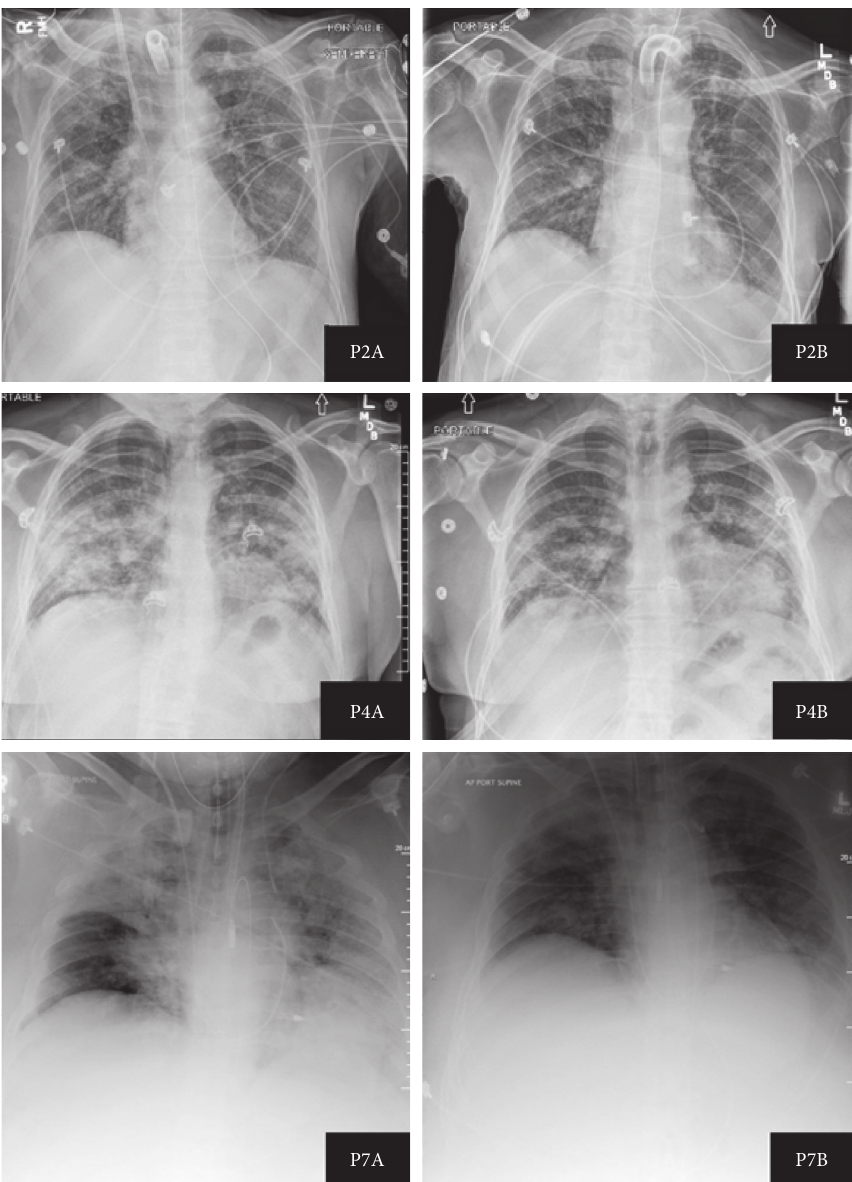
Figure 2: Chest X-rays of patients II, IV, and VII before (A) and after (B) treatment with dornase alfa. Imaging demonstrates improved resolution of opacities including for those who had prolonged mechanical ventilation (patients II, P2A/B, and VII, P7A/B) and for those not requiring mechanical ventilation (patient IV, P4A/B).